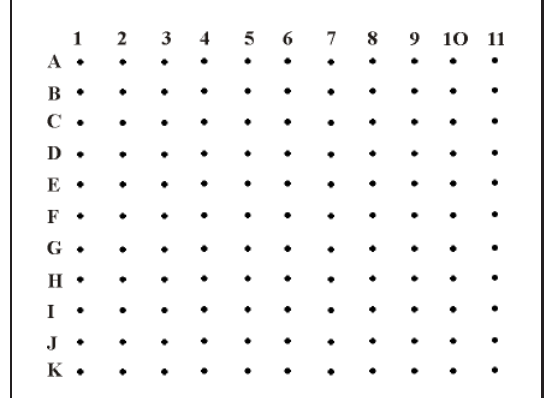
Figura 1. Croqui do grid de